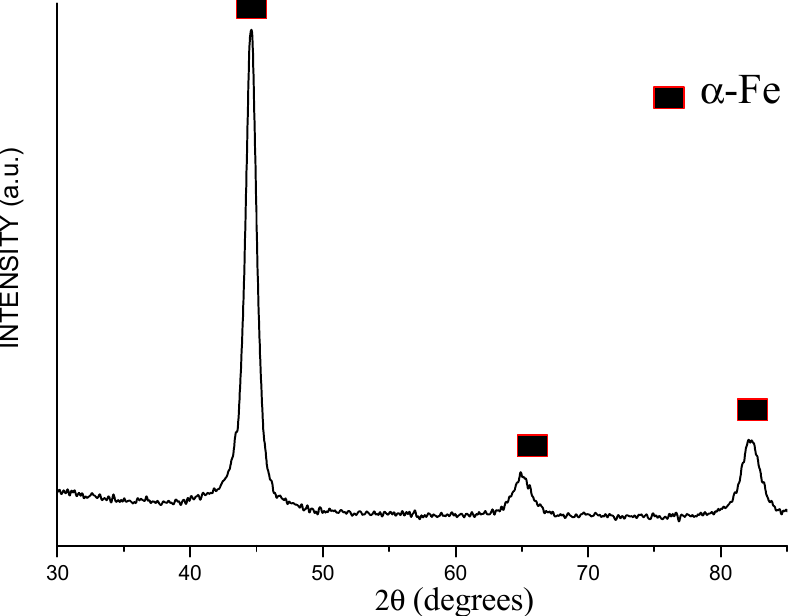
Figure 2. X-ray diffraction (XRD) pattern of the carbonyl iron powder.